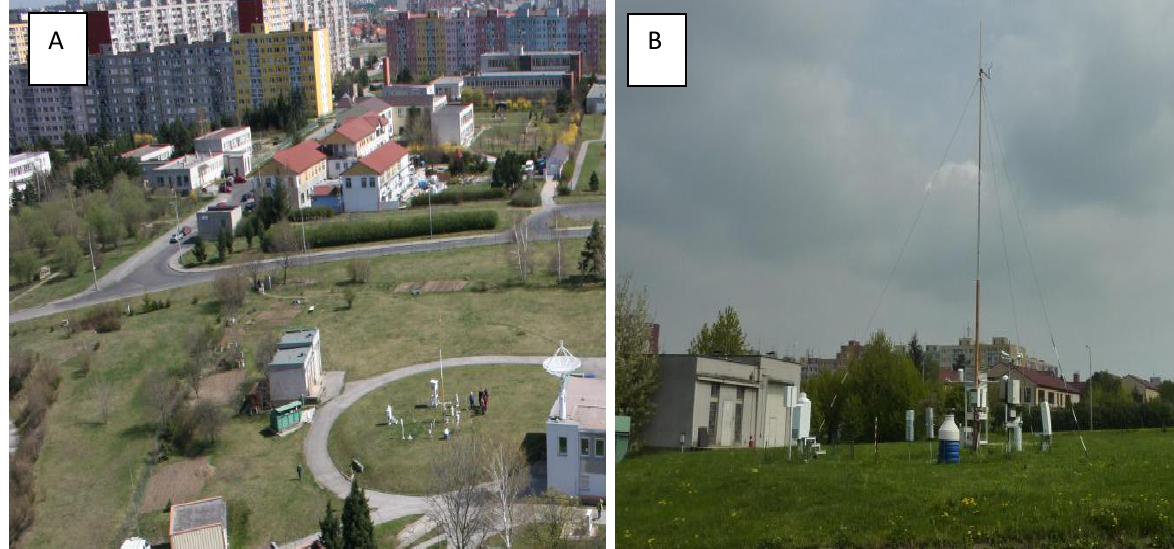
Fig. 4. Weather station in Prague-Libuš. View from the West (A), meteorological garden (B) (source: CHMI) A B